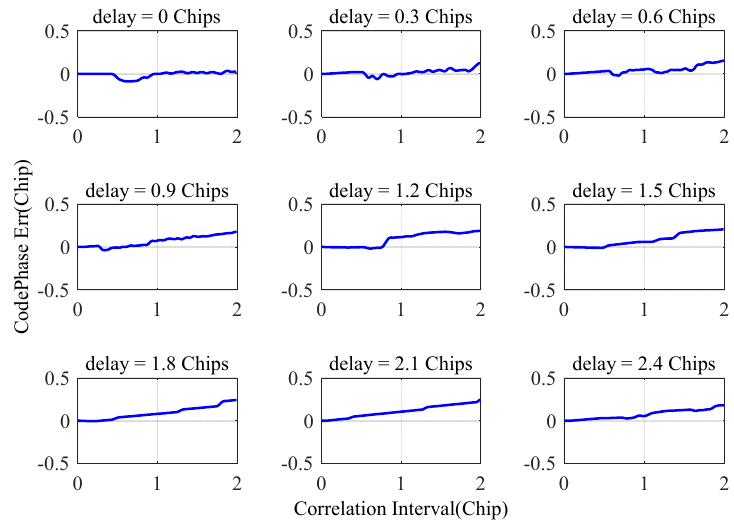
Figure 11. The impact of mixed interference on SCB.